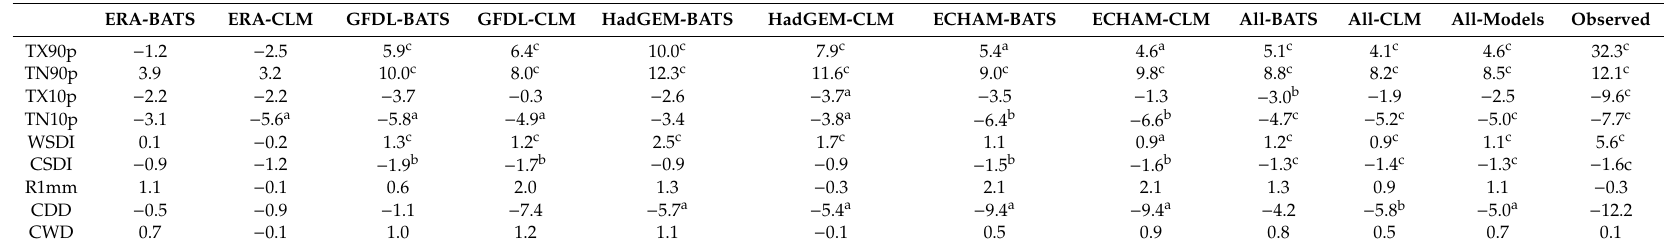
Note: The superscript a, b and c represents a significant level 90%, 95%, and 99%